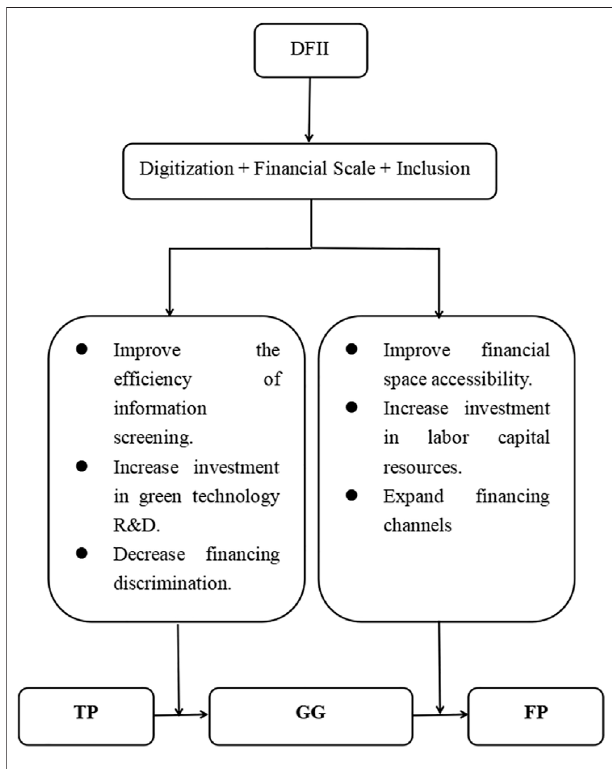
FIGURE 3 | The research framework. DFII=Digital Financial Inclusion Index; TP=Technological Progress; GG=Green Growth; FP=Floating